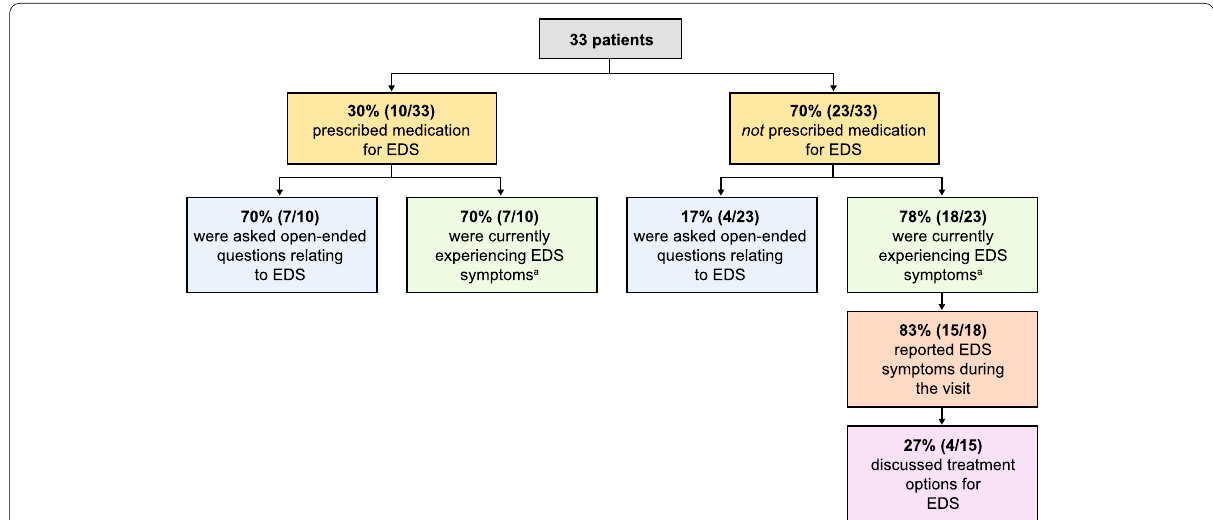
Fig. 3 Patient-physician interactions. Notes: a As reported by the patient during the visit and/or post-visit